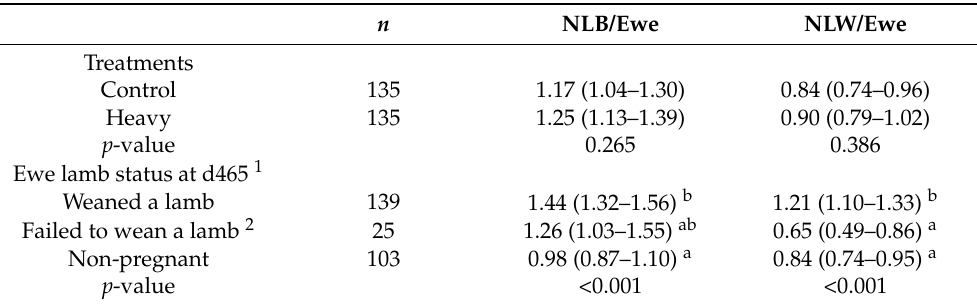
Table 2. The effect of treatment (control vs. heavy) and ewe lamb status at d465 1 (weaned a lamb, failed to wean a lamb 2 , non-pregnant) on least-square means (95% confidence intervals) of the yearly number of lambs born (NLB) and the yearly number of lambs weaned (NLW) per ewe presented for breeding over the first three years of production.